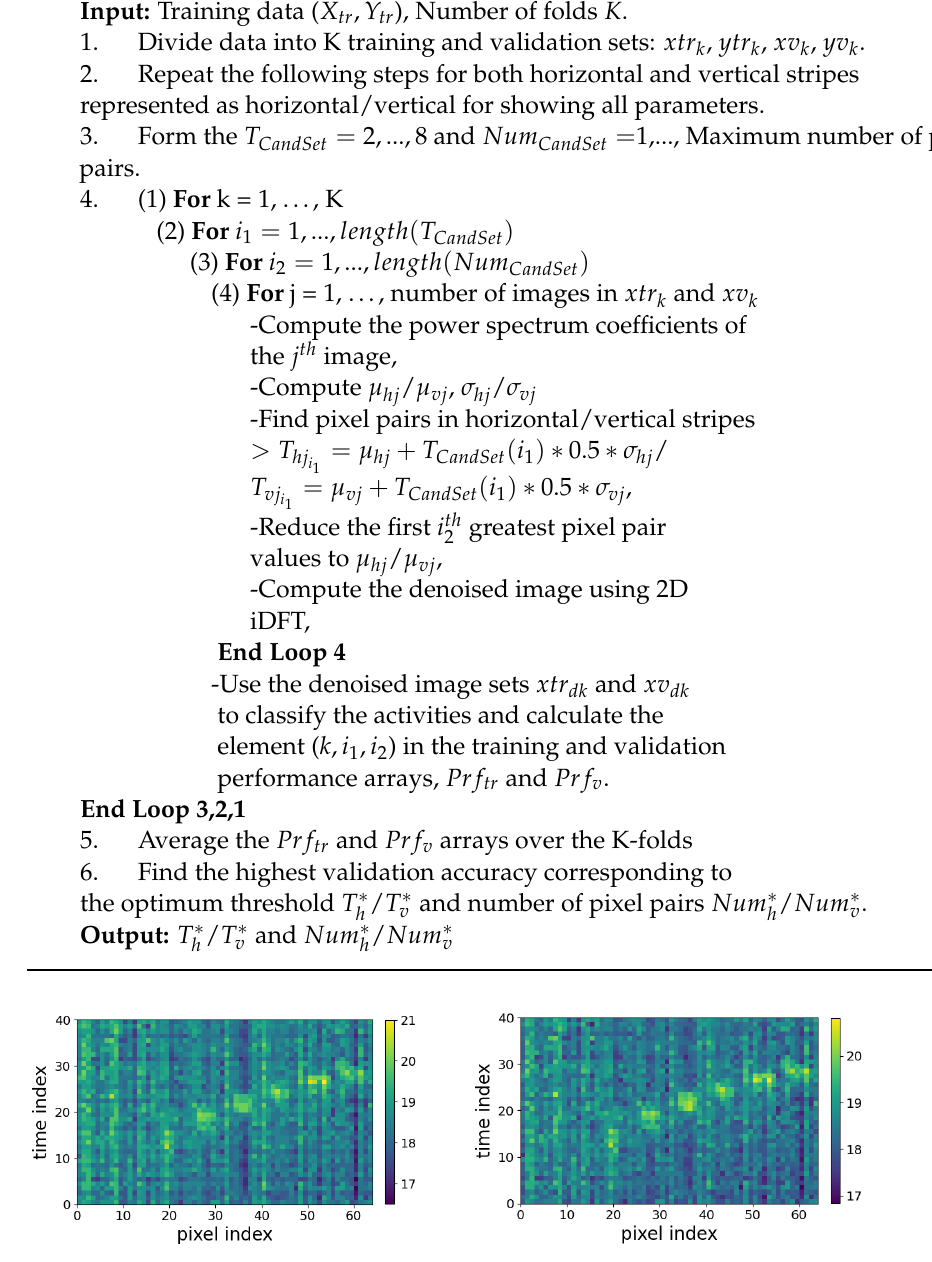
Algorithm 1: DFT-based periodic noise removal.